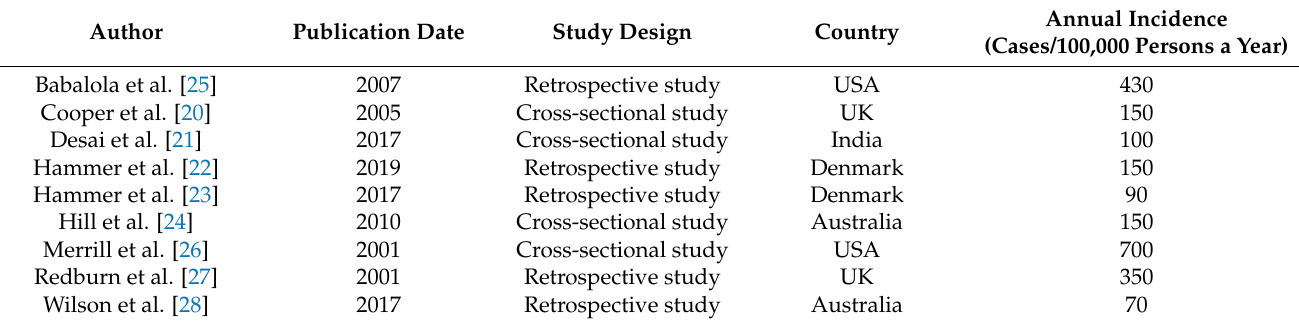
Table 2. Annual incidence of hysterectomies by country in women under